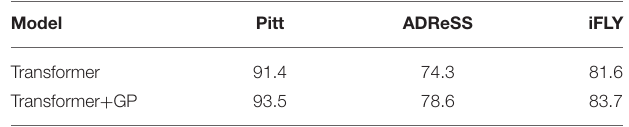
TABLE 4 | Accuracy on three